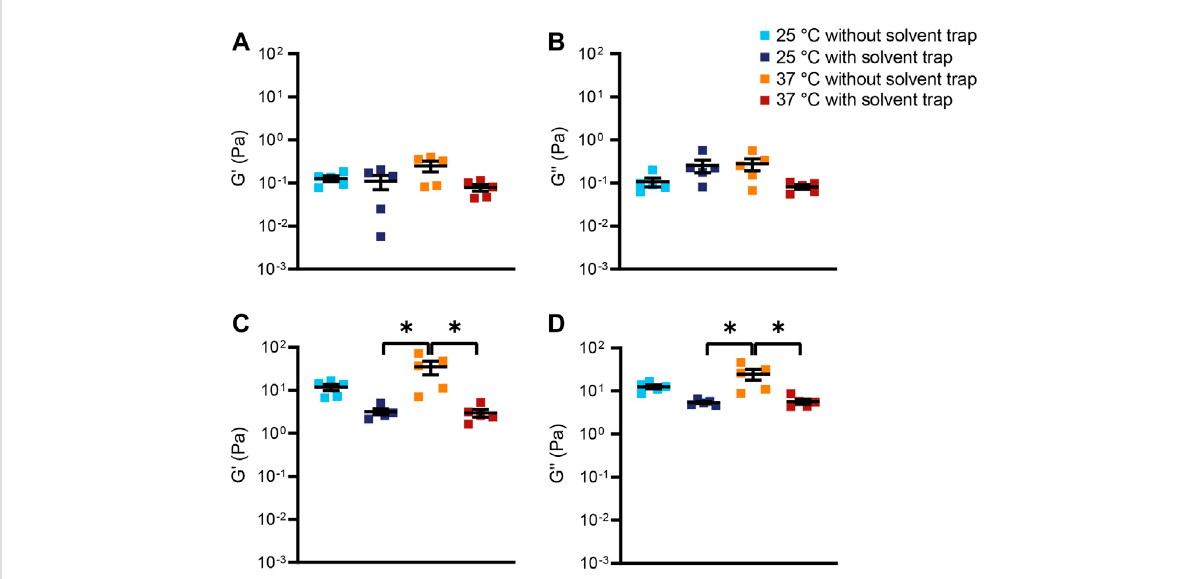
FIGURE 3 Viscoelasticproperties ofbovinesubmaxillary mucin. (A,C) StoragemodulusG ′ and (B,D) loss modulusG ″ of (A,B) 2%( n =5)and (C,D) 10%( n =